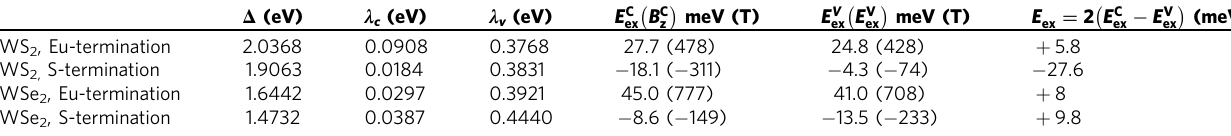
Table 3 Parameters of the minimal band model calculated from the DFT band structure results Δ